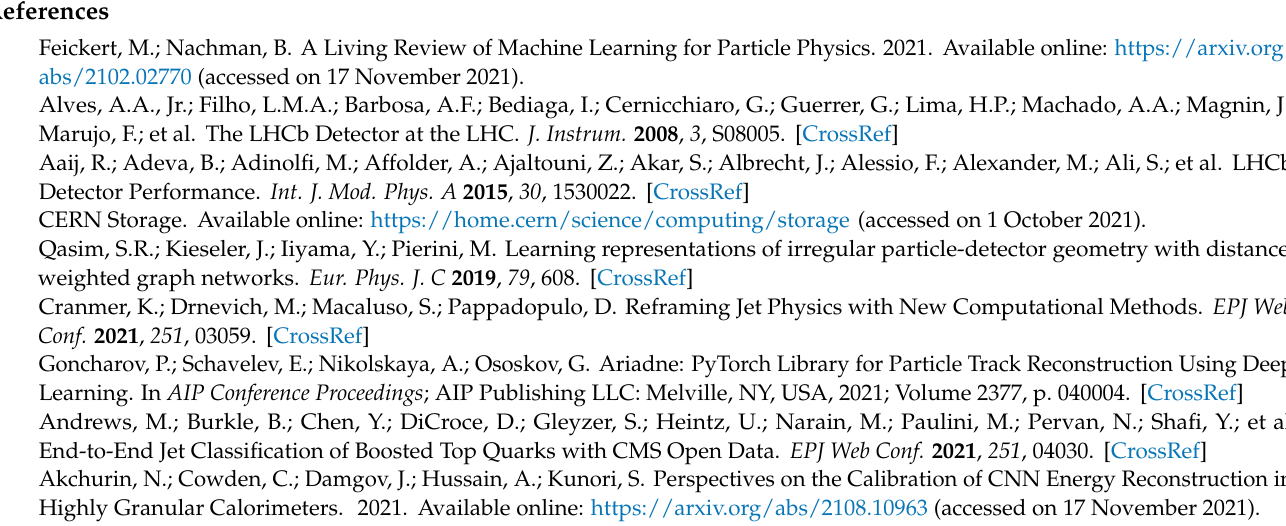
Table A14. Training time for each tool for the decay B